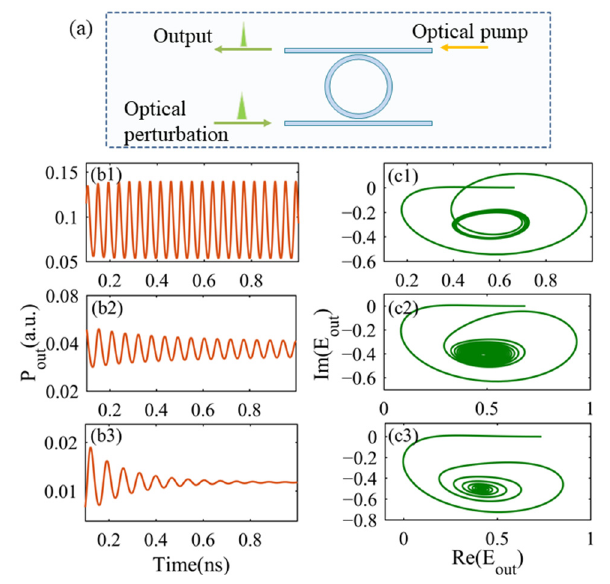
Figure 2. The proposed photonic neuron structure based on MRR ( a ); the output of the MRR neuron with P in = 0.1,0.05,0.01. ( b1 – c3 ); the corresponding phase portrait of the normalized light complex amplitude ( c1 – c3 ).